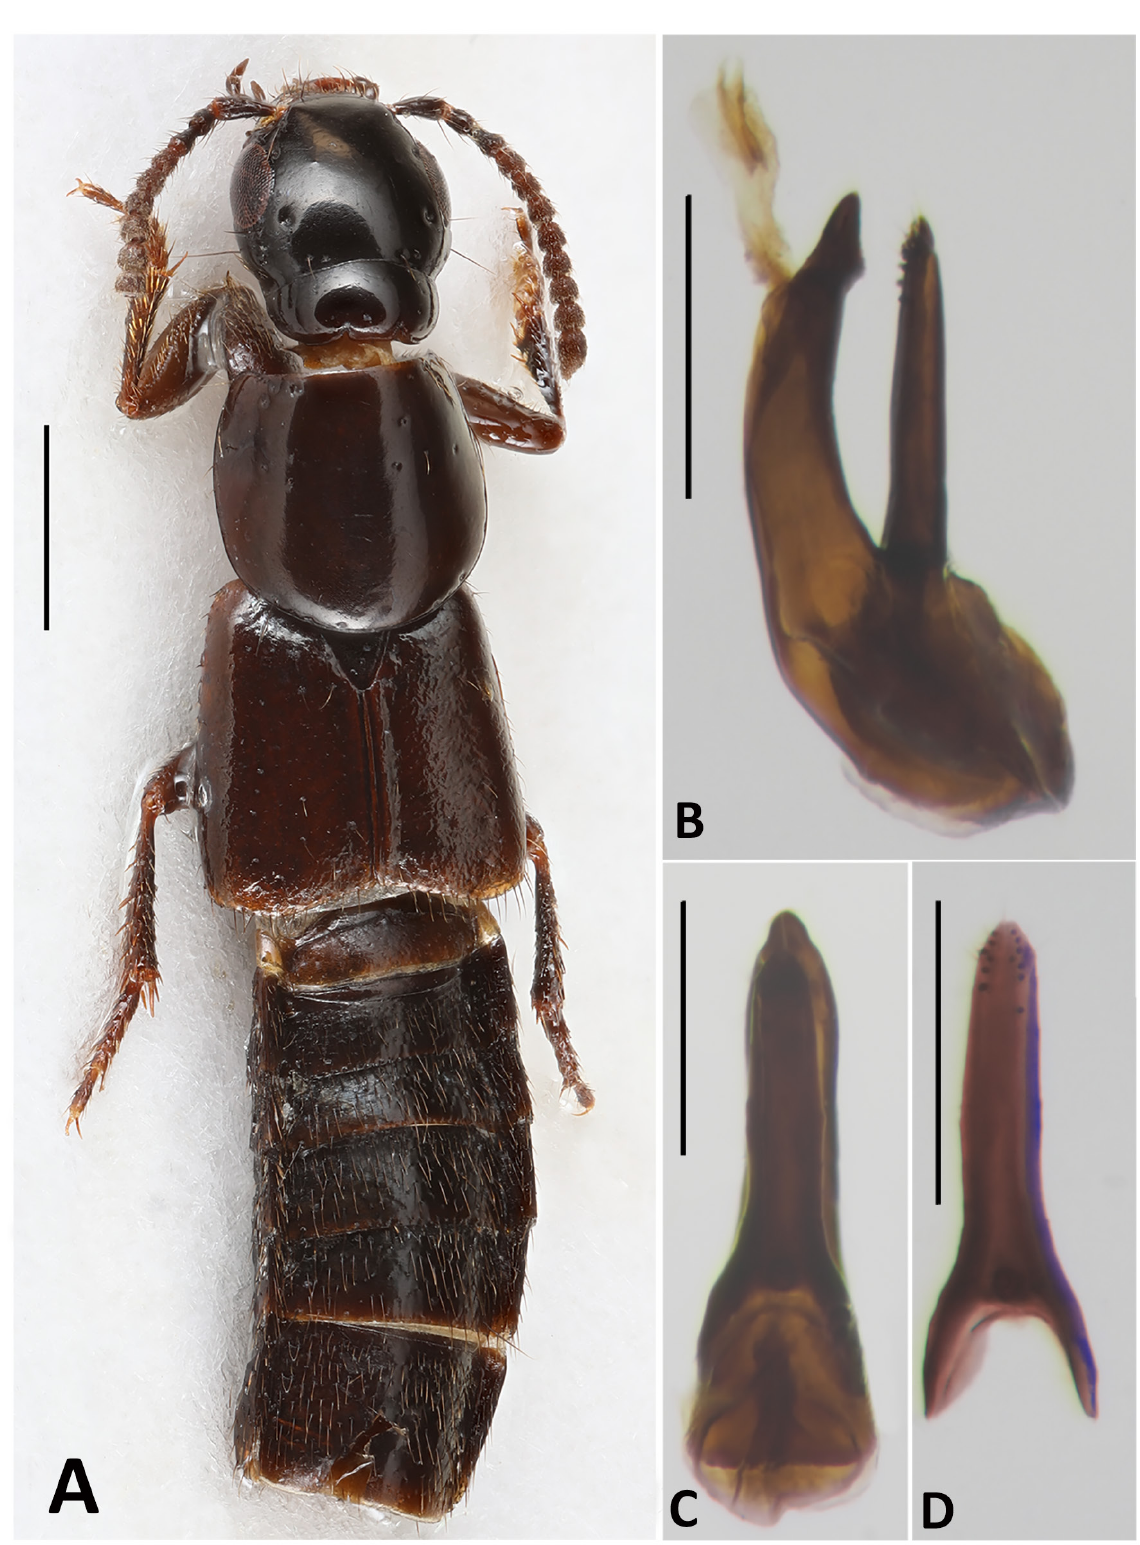
Fig. 4. Quedius sp. aff. gissaricus (ZIN). A . Habitus. B–D . Aedeagus. B . Lateral view. C . From parameral side. D . Paramere (underside). Scale bars: A = 1 mm; B–D = 0.5